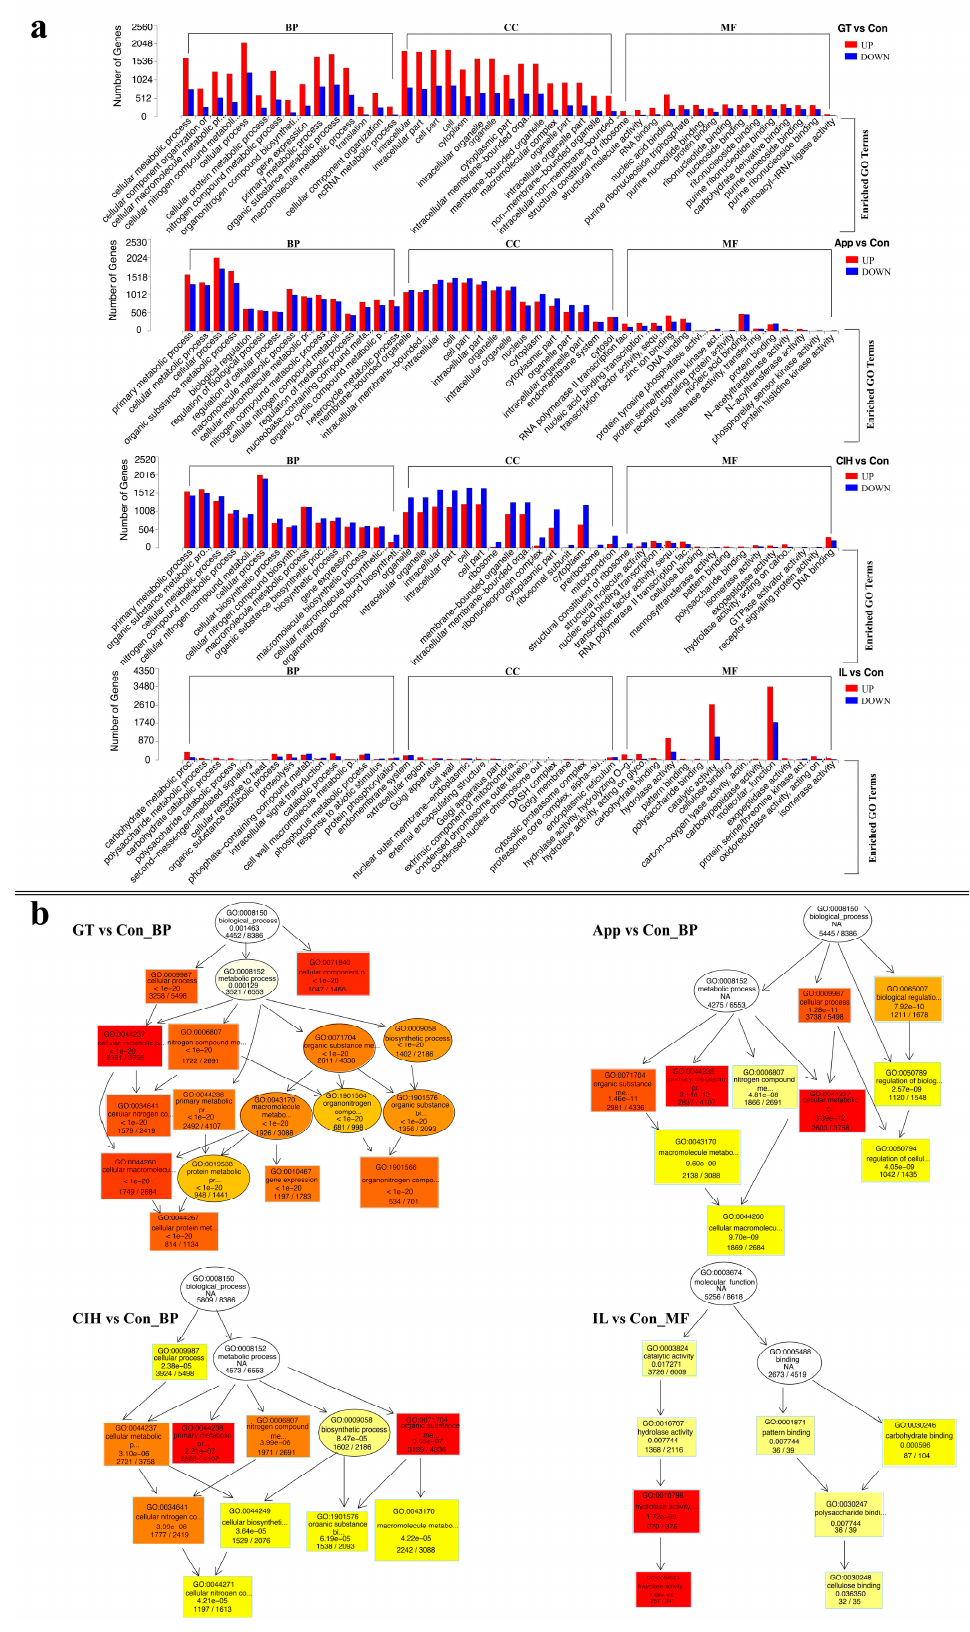
2 Figure 3. Gene ontology (GO) analysis of all di ff erentially expressed genes (DEGs) in di ff erent growth stages. ( a ) GO enrichment of four comparable groups in di ff erent growth stages of C. camelliae